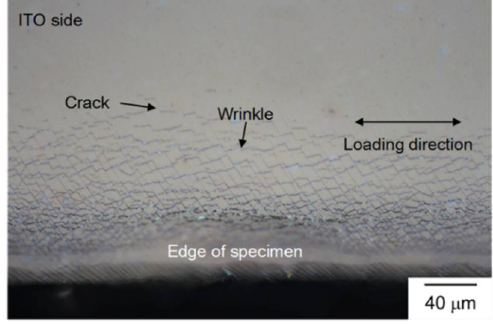
Figure 9. OM micrograph of ITO/PET sheet after tensile bending with a 5 mm curvature radius for 1000 h, as viewed from the ITO side.